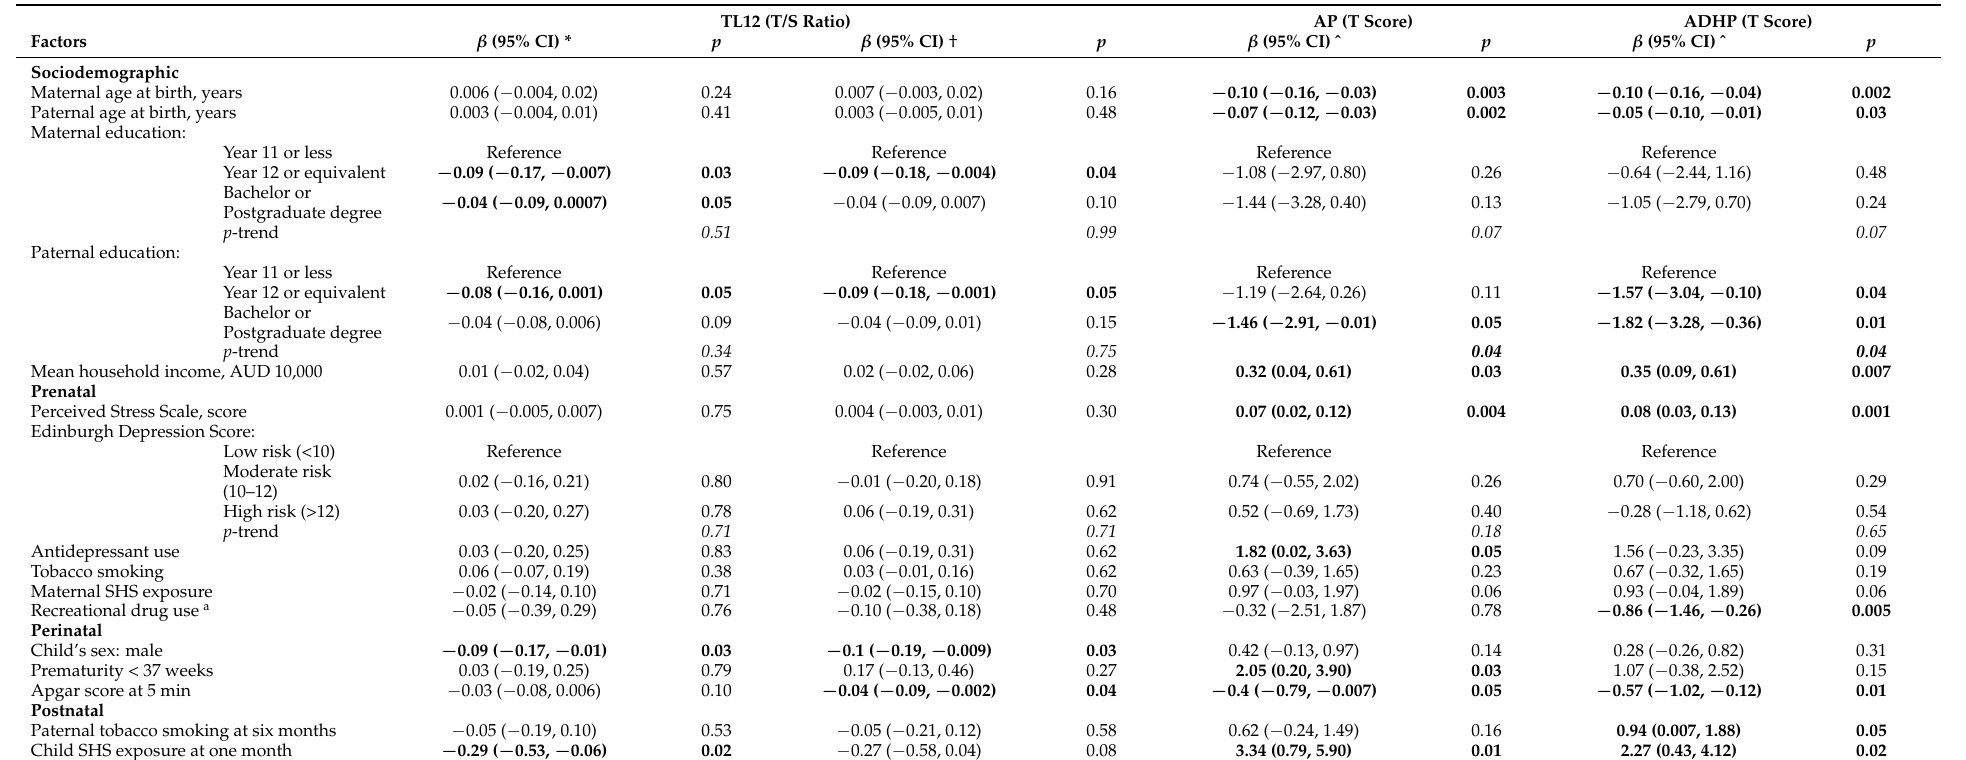
Table 3. Associations between key early life sociodemographic and environmental factors and TL12 or ADHD symptoms at age two